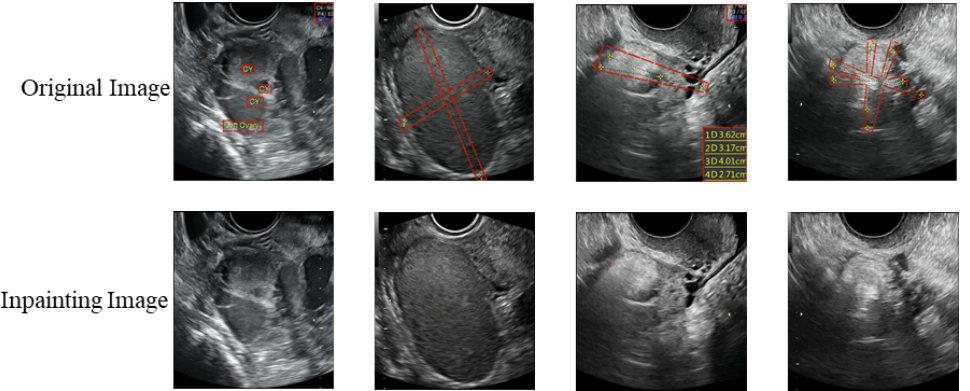
Figure 7. The results of our model for the inpainting of the symbolic regions in the ovarian ultra- sound